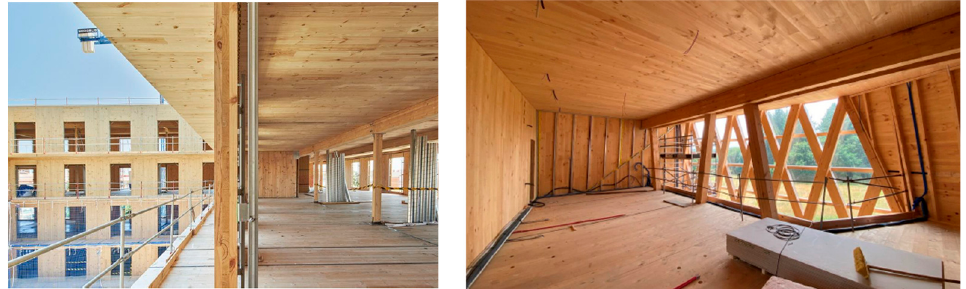
Figure 1. Residential building in Cornellá and Green Impulse Building in Lugo, build using GLT and CLT of Radiata pine (Source: Ref. [16]).